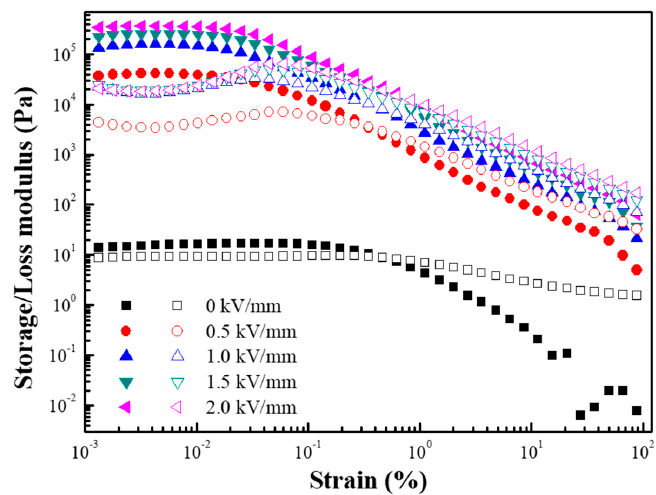
Figure 6. Storage ( G ′ , closed symbols) and loss ( G ″ , open symbols) moduli as a function of strain for PDPA/Fe 3 O 4 -based ER fluid (10 vol%, 50 cSt silicone oil) with constant angular frequency of 6.28 rad/s.